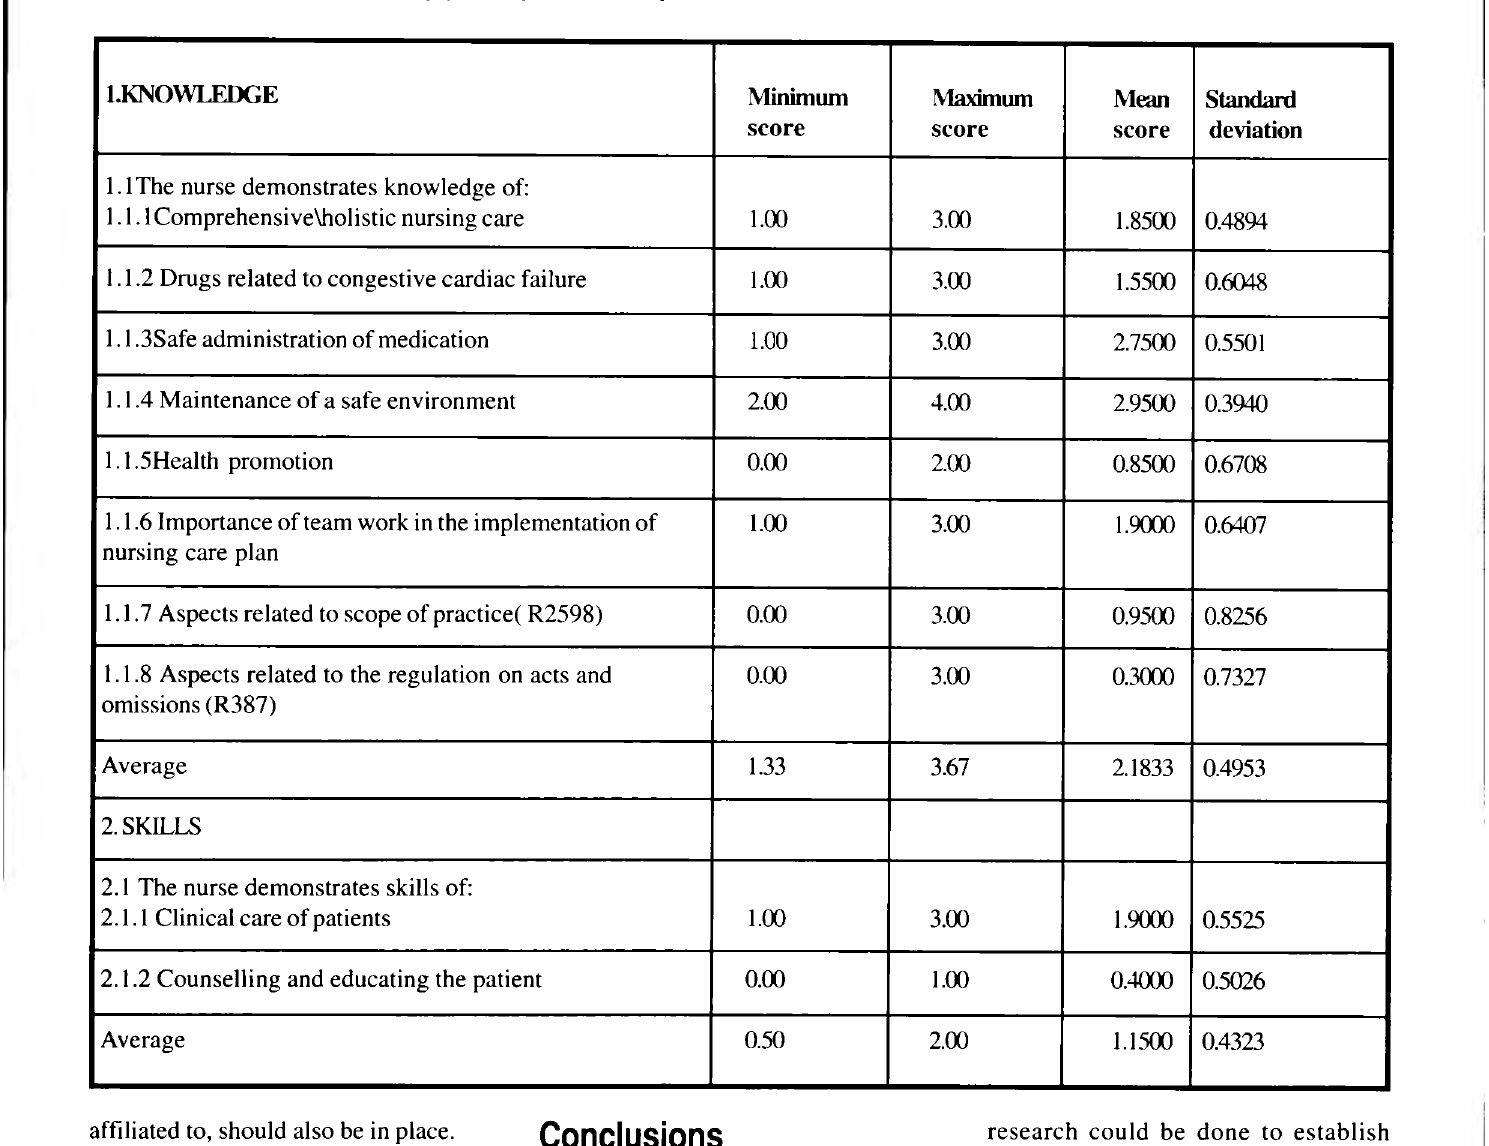
Table 1.5 Scores obtained by participants on